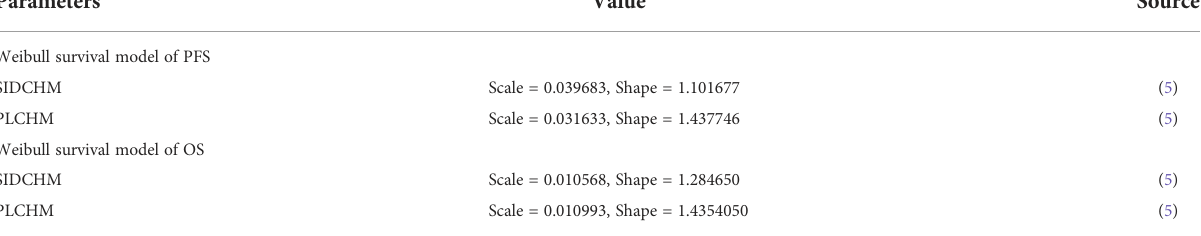
TABLE 1 Relevant parameters of survival distribution.